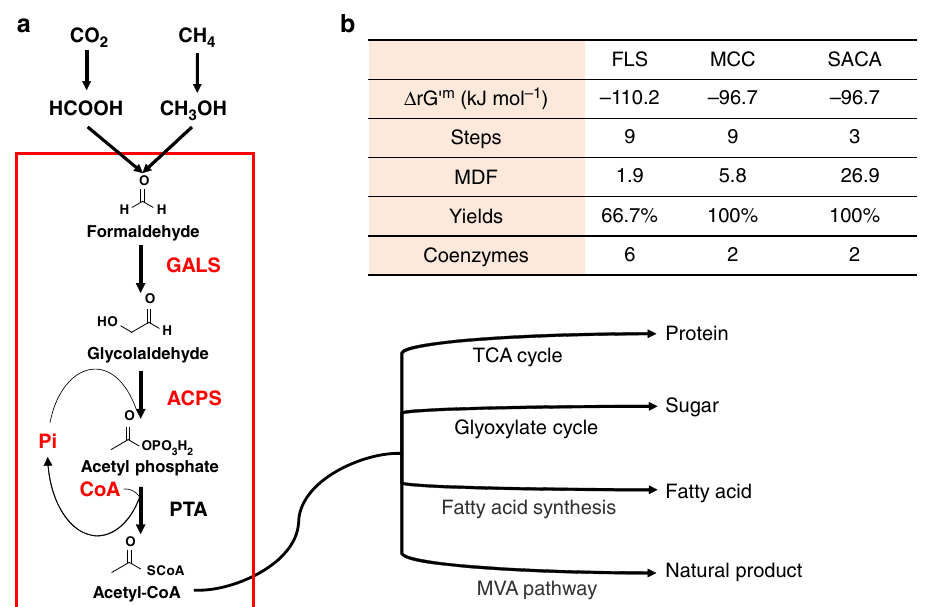
Fig. 1 Description and computational analysis of the SACA pathway. a The SACA pathway was highlighted in the red panel. The main feedstock of formaldehyde could be from methanol, formate and even methane and CO 2 . The product of acetyl-CoA could be used to generate major cellular nutrients. b The thermodynamic data of three designed pathways for acetyl-CoA synthesis were generated by the website of eQuilibrator (http://equilibrator. weizmann.ac.il). Δ rG ’ m : the total Gibbs energy change; Steps: the number of reactions from formaldehyde to acetyl-CoA in the studied pathways; MDF: the maximum driving force; Yields: the total yield of carbon in the studied pathways; Coenzymes: the number of coenzymes is used in the studied